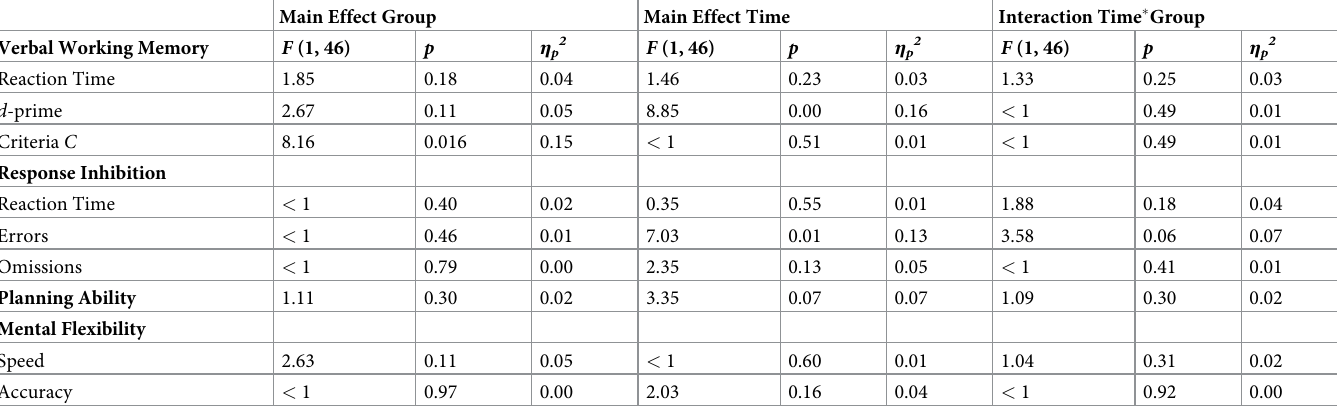
Table 3. Main and interaction effects of different neuropsychological performance measures.